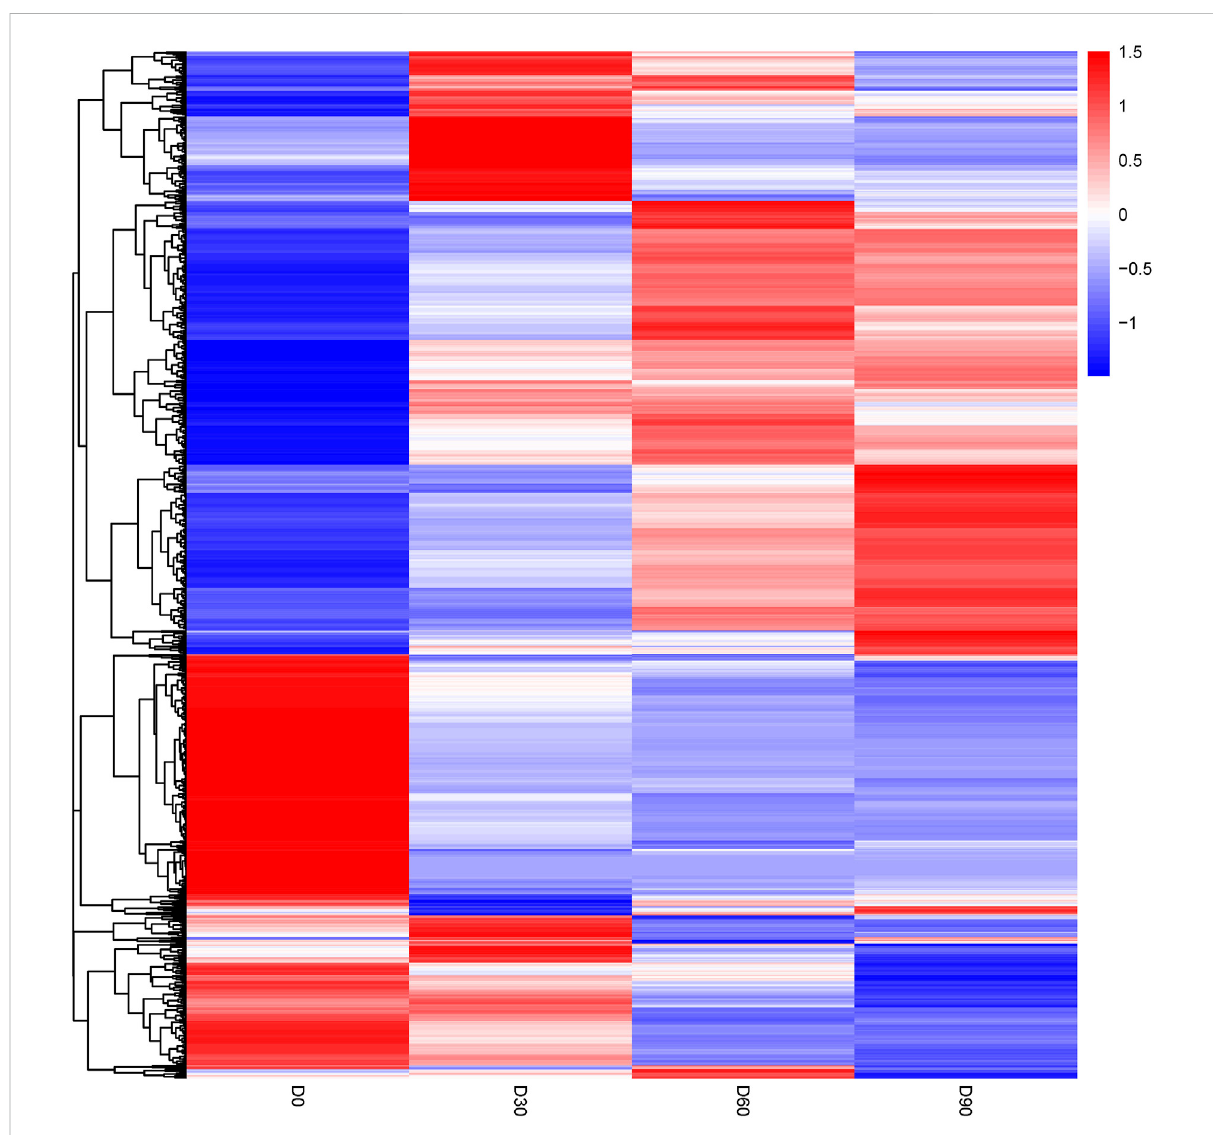
FIGURE 3 Heat map of differentially abundant proteins in rumen epithelium at the age of day 0, day 30, day 60 and day